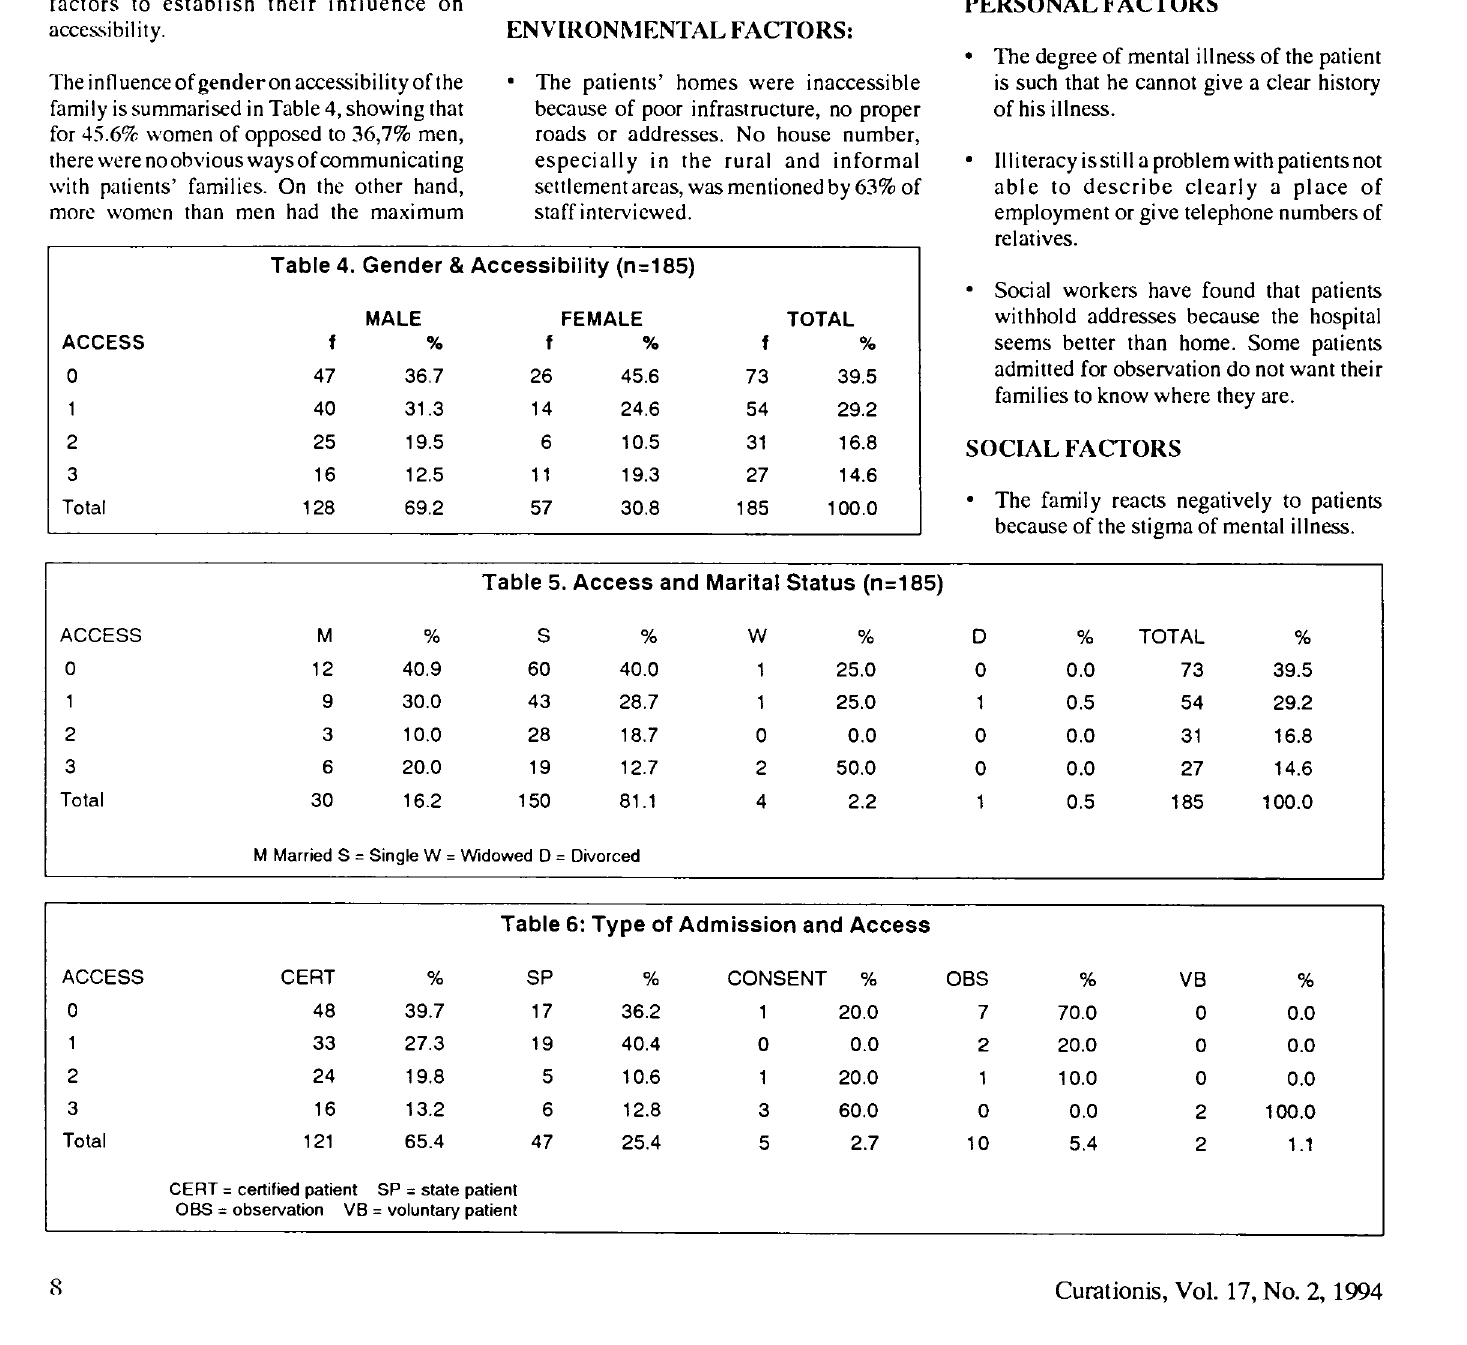
Table 5. Access and Marital Status (n=185)